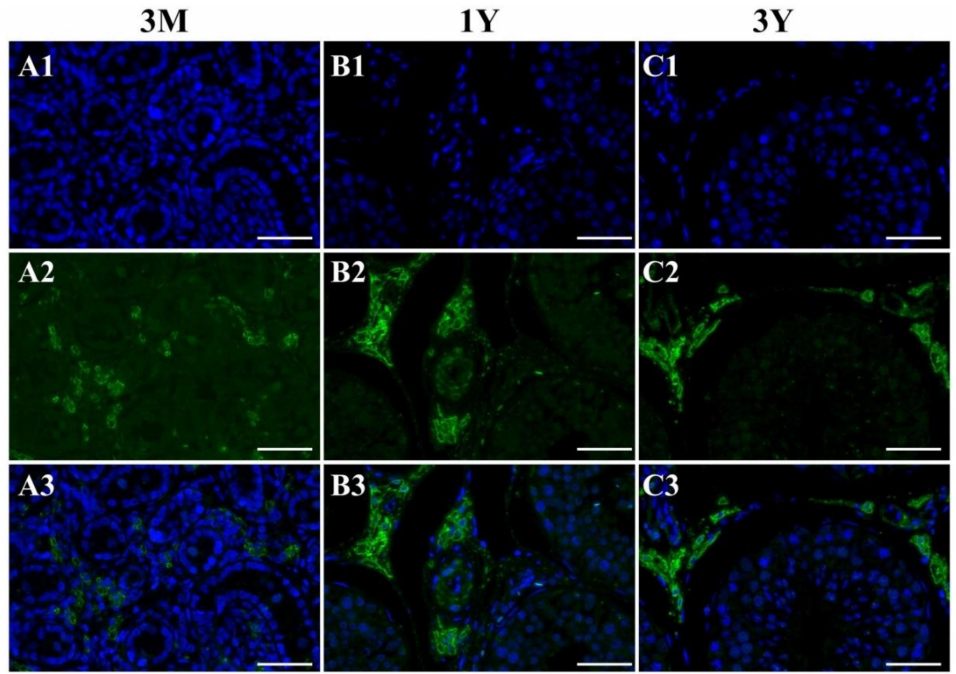
Figure 7. Immunofluorescence staining of the GLOD4 protein in developmental Tibetan sheep testes. ( A1 – C1 ) 4, 6-diamidino-2-phenylindole (DAPI) for nuclei staining (blue); ( A2 – C2 ) GLOD4 protein (green); ( A3 – C3 ) merge; bar = 50 µ m. The experiment was biologically repeated eight times, and technically repeated two times for each biological replicate. 3M: 3 months old; 1Y: 1 year old; 3Y: 3 years